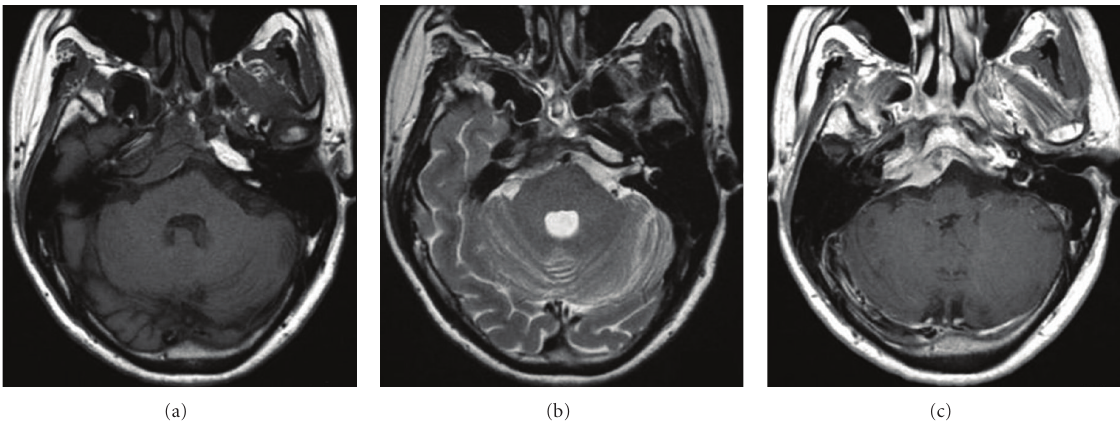
Figure 1: (a) Cerebral T1-weighted MRI shows a homogeneous, low-signal mass in the petrous bone from the right clivus. (b) Cerebral T2-weighted MRI reveals a homogeneous, high-signal mass in the petrous bone from the right clivus. (c) Cerebral T1-weighted MRI with gadolinium shows a heterogeneously enhanced mass in the petrous bone from the right clivus.